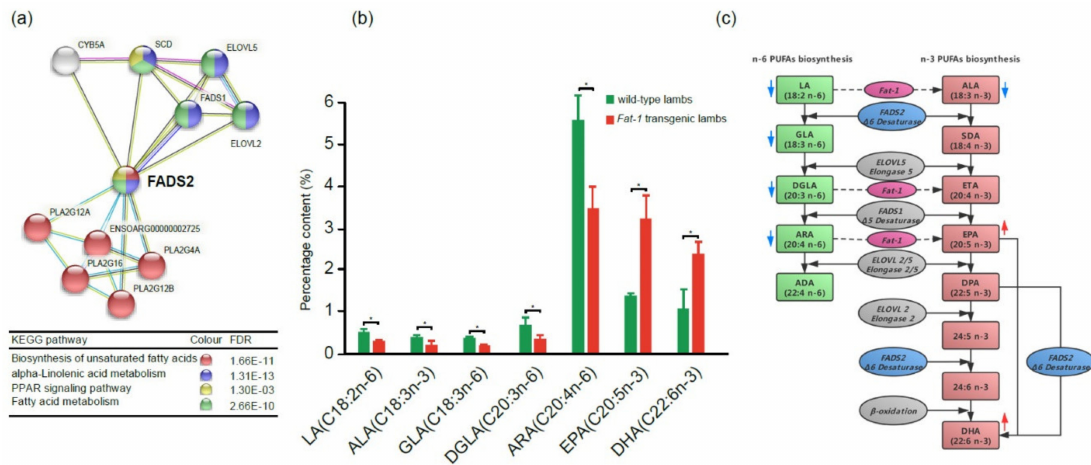
Figure 6. FADS2 in the PUFA biosynthesis-related PPI network and roles of Fat-1 and FADS2 in n -6 and n -3 LC-PUFA (long-chain polyunsaturated fatty acids) biosynthesis pathways. ( a ) The FADS2 gene is involved in four key pathways related to biosynthesis and metabolism of PUFAs. Di ff erent colored balls represent di ff erent signaling pathways. ( b ) The contents of n -3 and n -6 PUFAs in the gluteus tissues of Fat-1 transgenic lambs and wild type lambs (t-test, * p < 0.05). ( c ) Diagram of n -6 and n -3 PUFAs biosynthesis pathways and roles of Fat-1 and FADS2 in the pathways, modified from F. H. Chilton et al. 2017 [17]. The red arrow or blue arrow beside each PUFA means its content increased or decreased, respectively, in Fat-1 transgenic sheep when compared to wild type